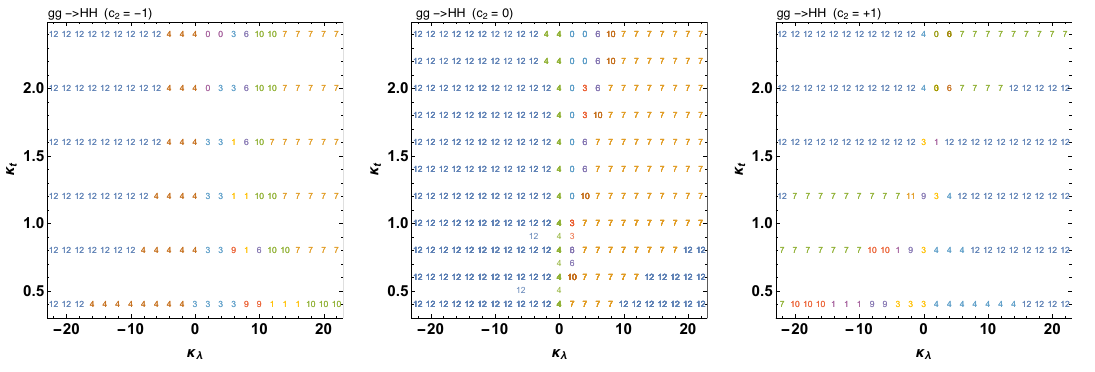
Figure 8 . Map of the closest shape benchmarks in the κ λ − κ t plane for different values of c 2 .